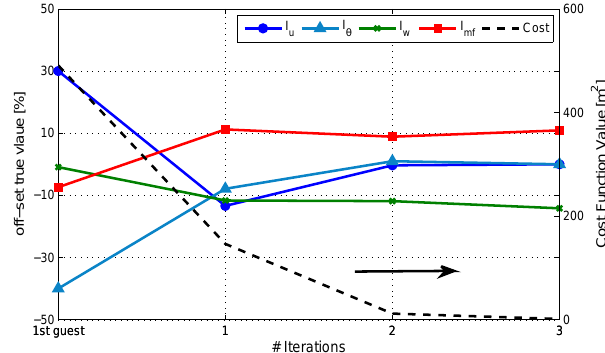
Figure 4. Convergence of cost function (dashed line, right axis) and individual convergence of each invariant to the true value (solid lines, left axis) as a percentage difference. Assimilation windows = 15min (1assimilationmin − 1 ).